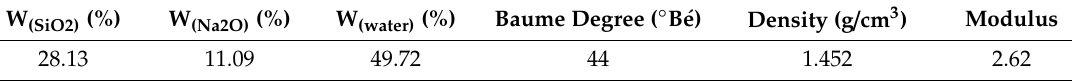
Table 2. Physical properties and chemical compositions of water glass.